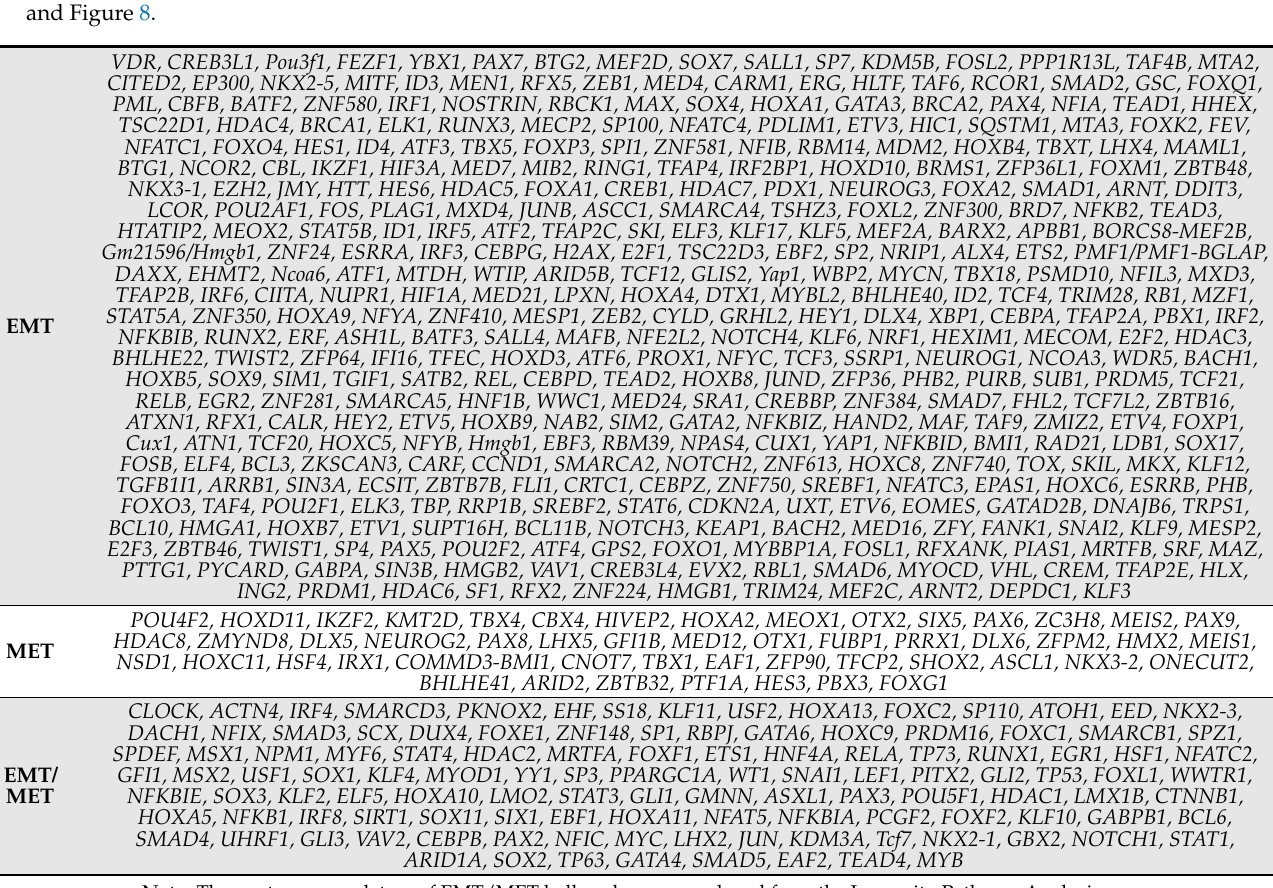
Table 3. Upstream regulators of both EMT and MET. Transcription factors involved in EMT, MET, or EMT/MET processes were listed as switch factors. The identified upstream regulators were based on molecular interactions, as shown in Table 2 and Figure